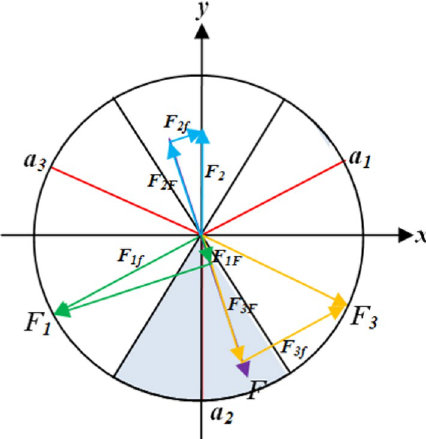
Fig. 10 Steering and pad forces when α